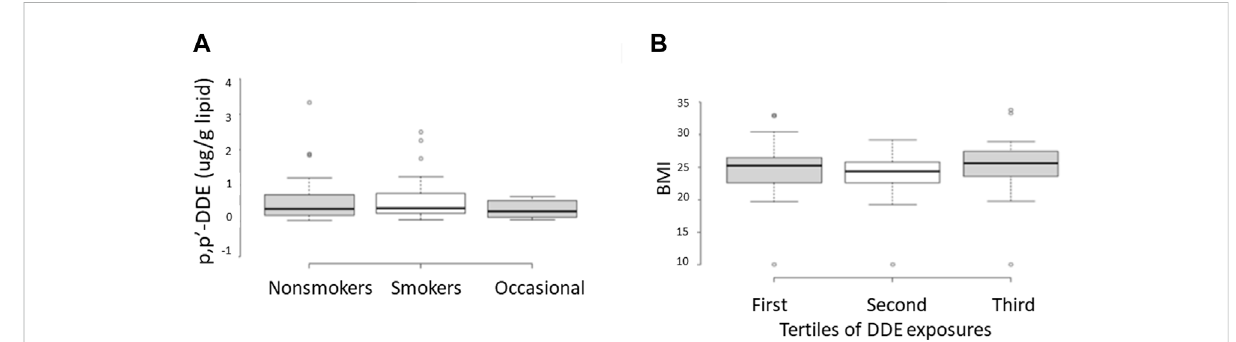
FIGURE 3 Relationship between serum concentrations of DDE and smoking status (A) or body mass index (BMI) (B) . In B, the range of BMIs is shown for individuals determined to be in the fi rst, second, and third tertiles with respect to levels of serum DDE. Samples from the fi rst and third tertiles were